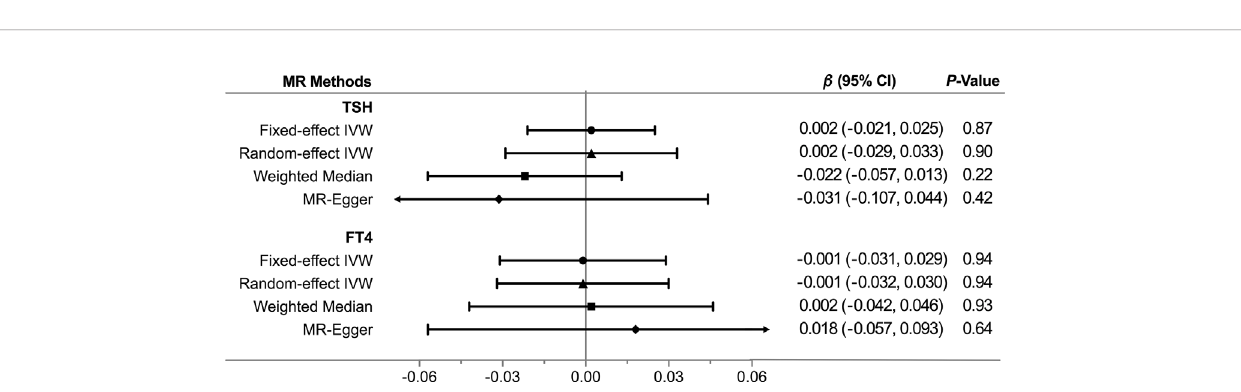
FIGURE 2 | Primary results of the Mendelian randomization analysis. Individual SNP-effect on birth weight (point and vertical line) against its effect on TSH or FT4 (point and horizontal line) was delineated in the background. The causal estimate given by the IVW method ( fi tted line) for the effect of maternal TSH on birth weight was shown in (A) , while the overall effect for the casual association of maternal FT4 with birth weight was presented in (B) . FT4, free thyroxine; IVW, Inverse variance weighted; SNP, single nucleotide polymorphism; TSH, thyroid stimulating